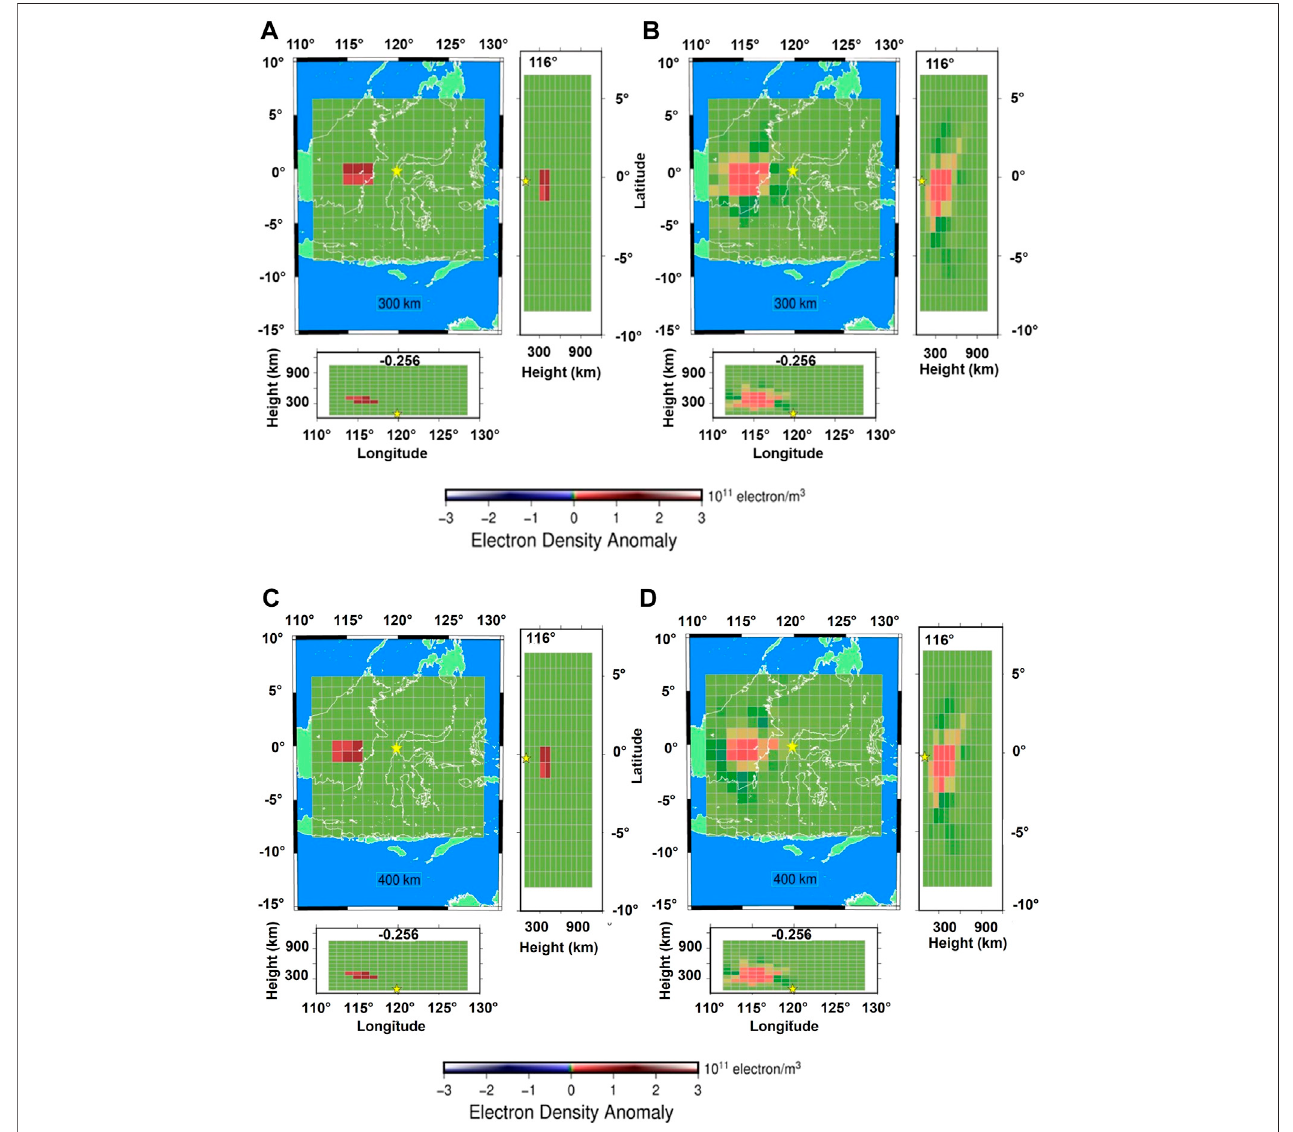
FIGURE5| Secondresolutiontestforapairofpositiveandnegativeanomalies. Theleftandrightpanelsarehorizontalviewsandlatitudinalpro fi lesoftheassumed pattern anomalies (A,C) and the output from the 3D tomography (B,D) . On the right panel is shown a cross-section of the main pro fi le along the longitude of 116 ° E. Meanwhile, the lower panel is a cross-section of the main pro fi le along the latitude of 0.256 o S. So, the right and lower panels describes the pro fi le in the dimensions of a given longitude and latitude, respectively. The 3D tomographic model with latitude and longitude pro fi le formation is also used by Mua fi ry and Heki (2020) in describing the sporadic conditions in